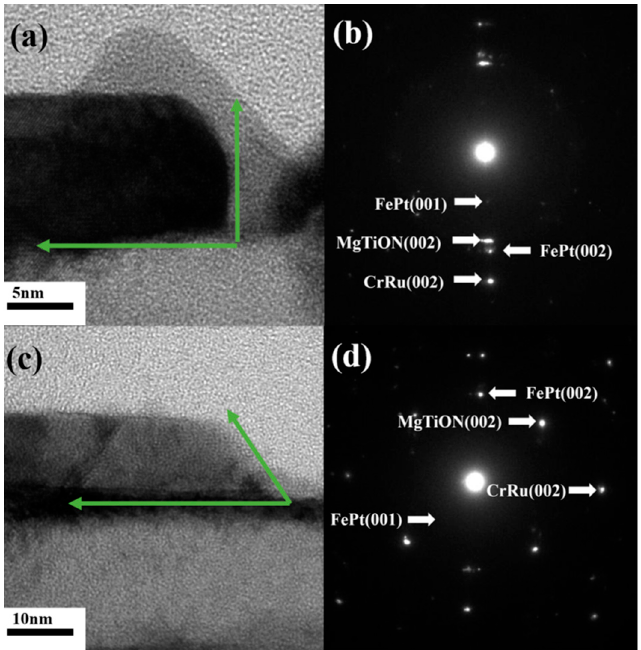
Figure 4. ( a , c ) The magnified cross-sectional TEM images and ( b , d ) selected area diffraction (SAD) patterns of Figure 3b,d.